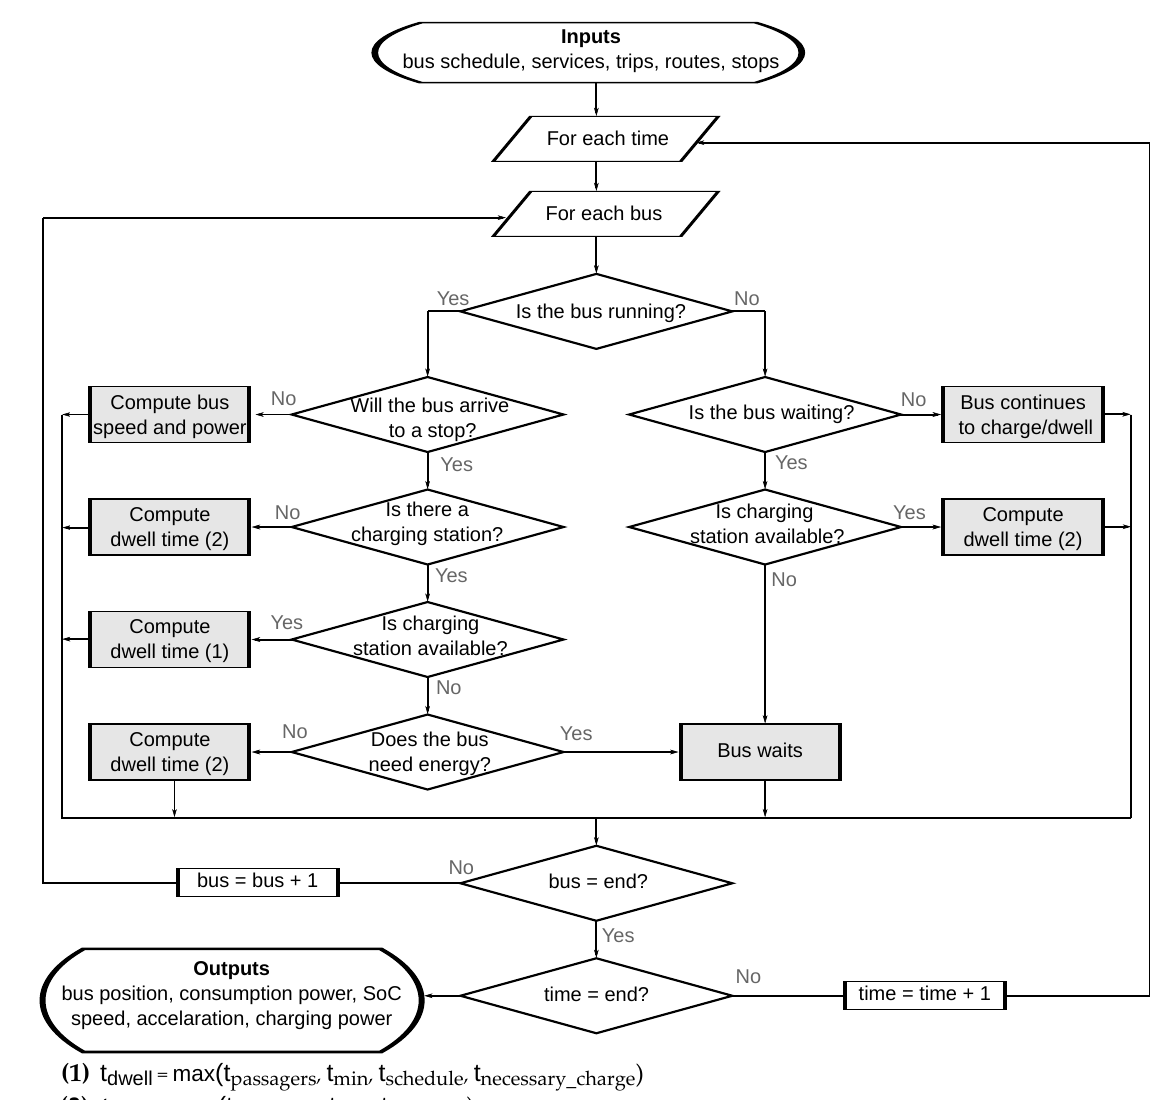
Figure 5. Flow chart of the simulation of the bus fleet